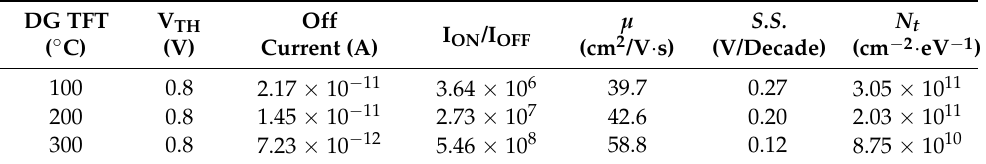
Table 2. Electrical characteristics of a DG TFT with a 33% O 2 plasma–treated IGZO channel layer and annealed at temperatures 100, 200, and 300 ◦